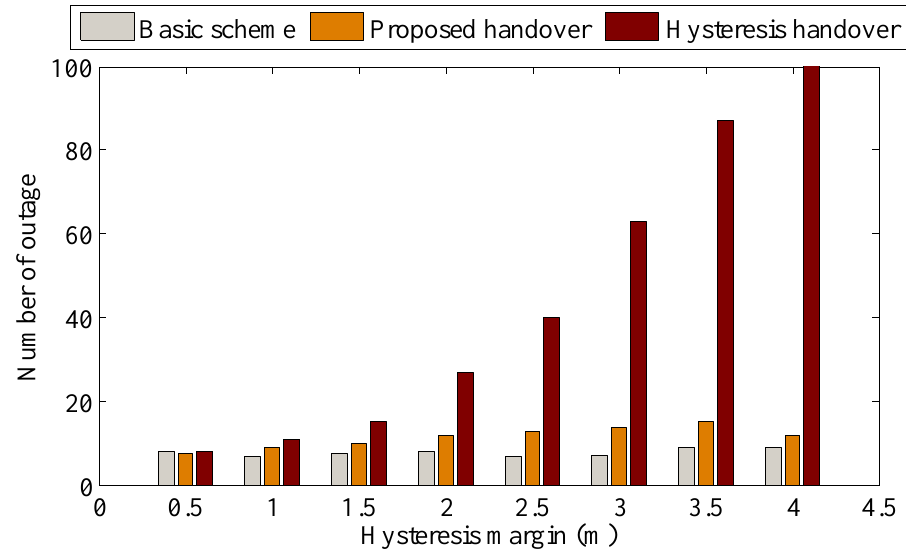
Comparison of the number of outage in the BSN deployment case without constructive